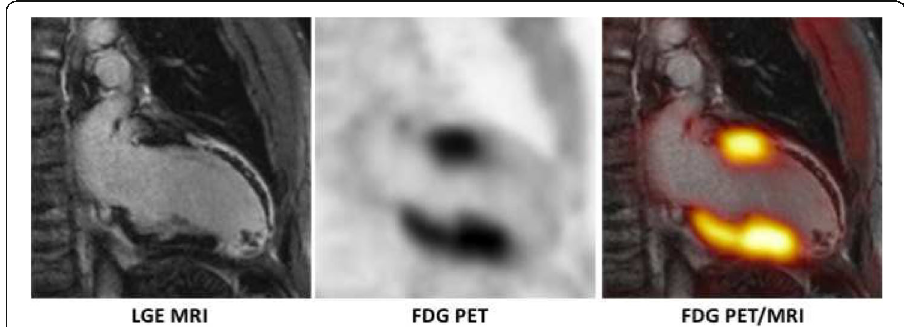
Fig. 5 Viability assessment with hybrid FDG PET/MRI. A FDG PET/MRI (viability protocol with glucose loading) was performed in a mid-aged man early after acute ST-elevation myocardial infarction with occlusion of the left anterior descending (LAD) coronary artery. The inferior wall and the basal part of the anterior wall demonstrate no late gadolinium enhancement (LGE) and a normal FDG uptake and are therefore PET/MRI vital. The remaining parts of the heart in this two-chamber-view demonstrate transmural LGE with subendocardial microvascular obstruction in the anterior wall and almost absent FDG uptake and are therefore judged PET/MRI